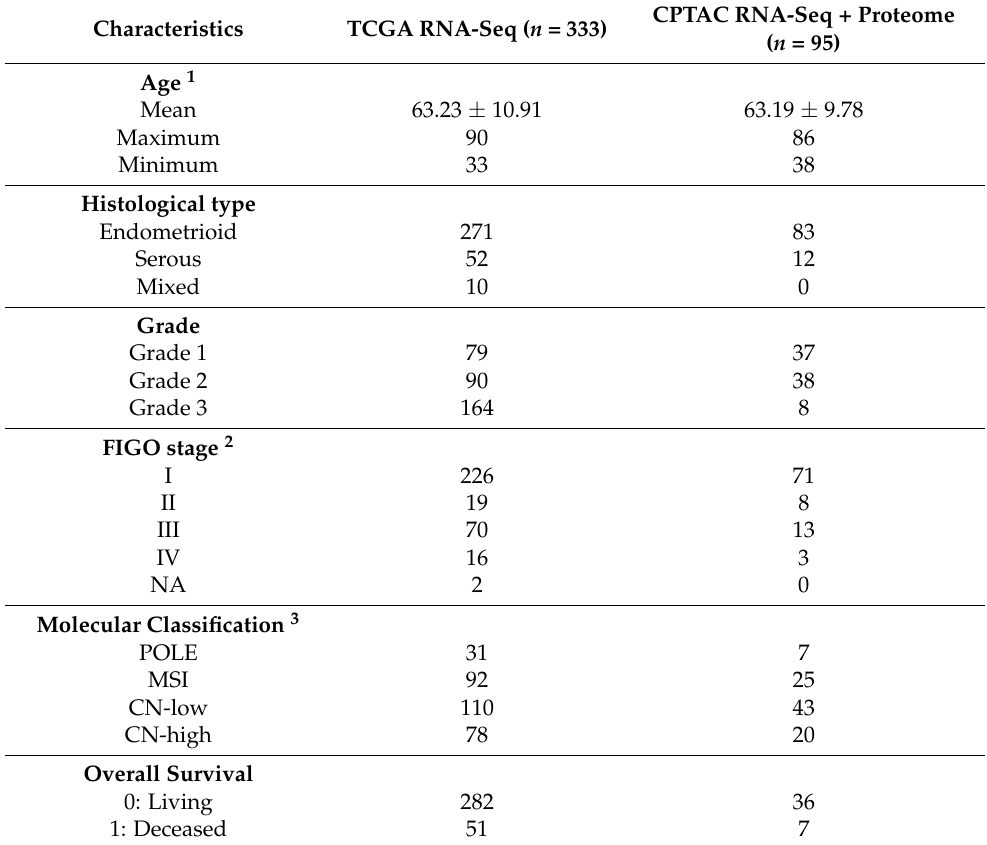
(CPTAC-proteome) data corresponding to 95 EC patients was used for the analysis. Table 1 details the clinical information of the EC patients used for the analysis of this study. Table 1. Clinical, pathological, and molecular information of the patients. Detailed clinical, patholog- ical, and molecular information of the patients included in this